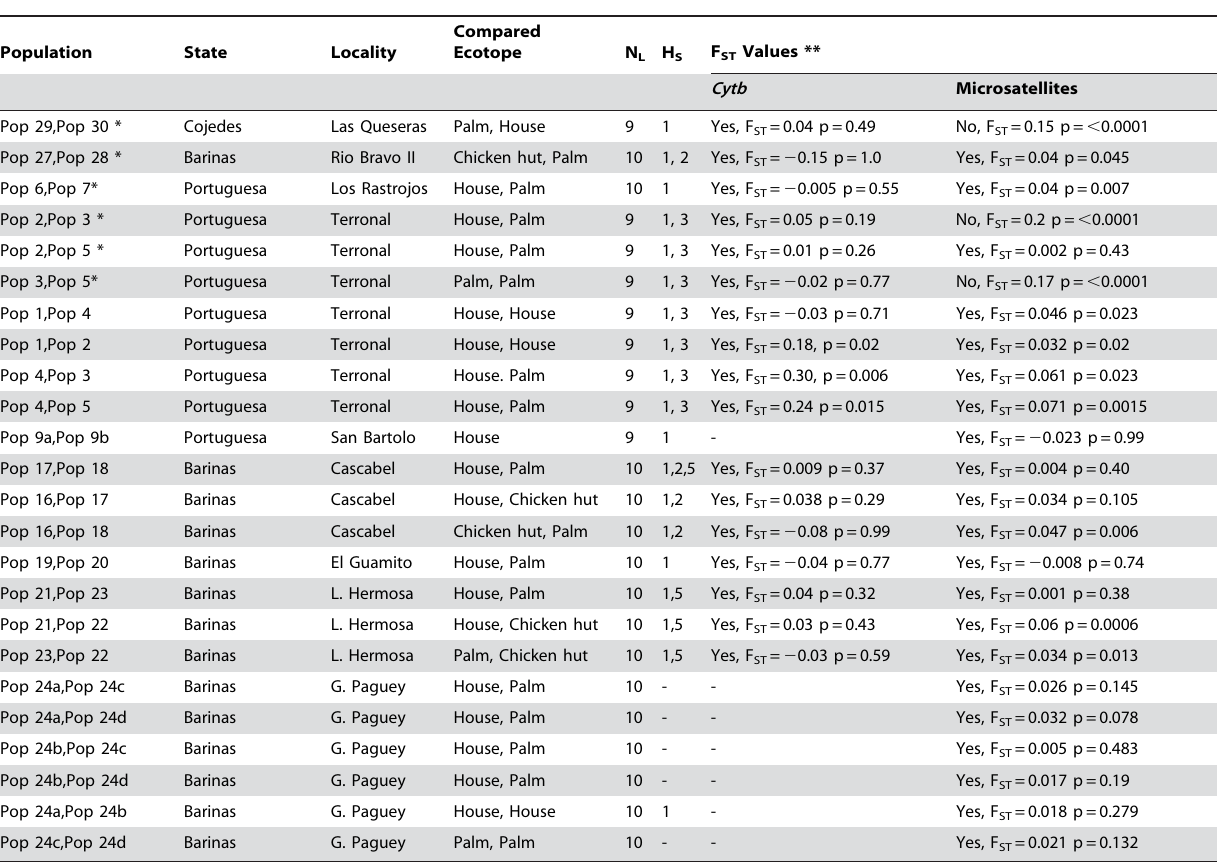
Table 4. Summary of